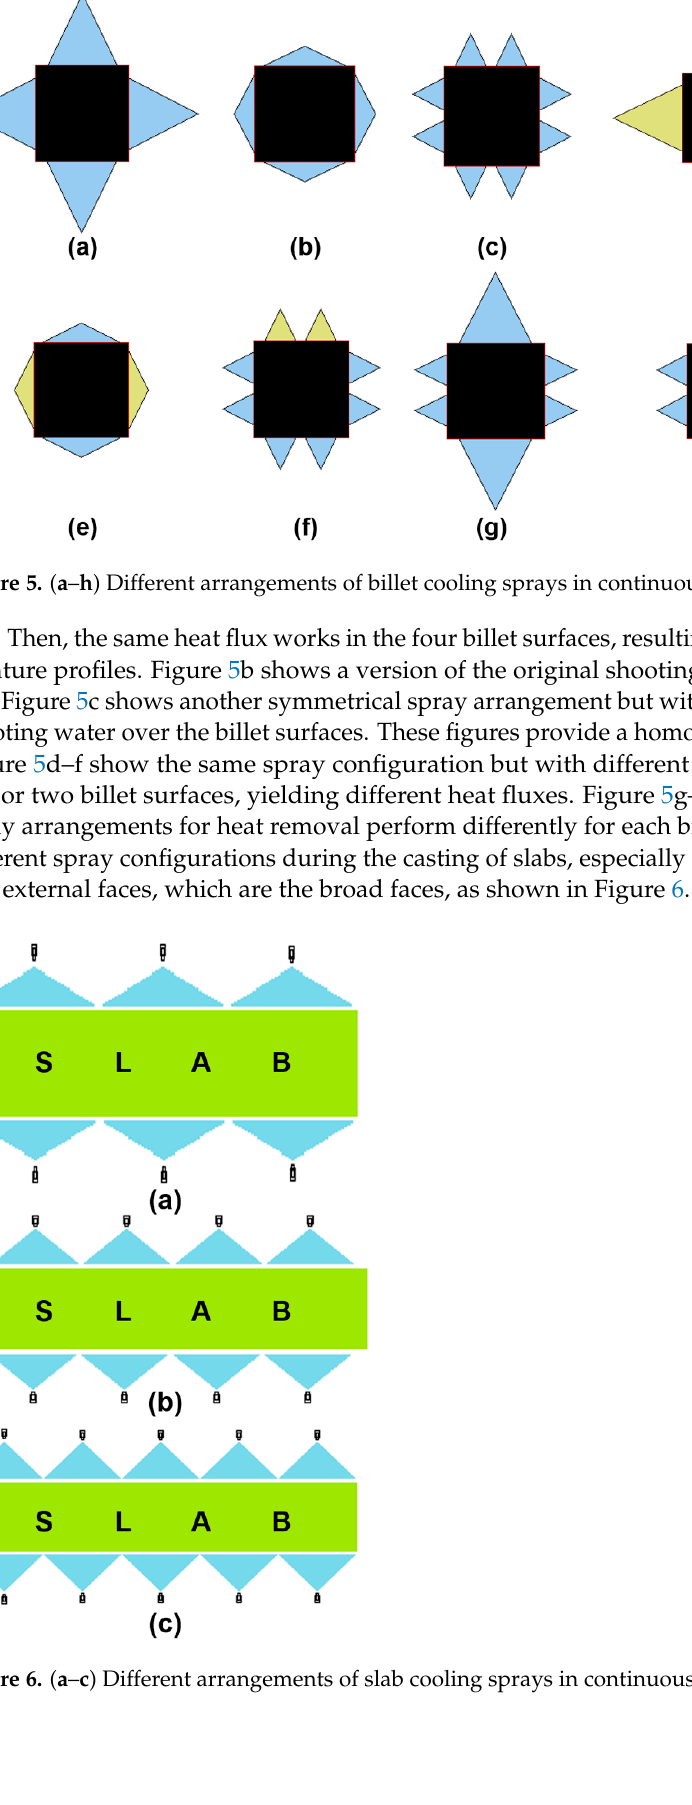
130 Table 2. Temperatures of the steel. 𝑻 𝒂𝒓𝒊𝒒 (°C)